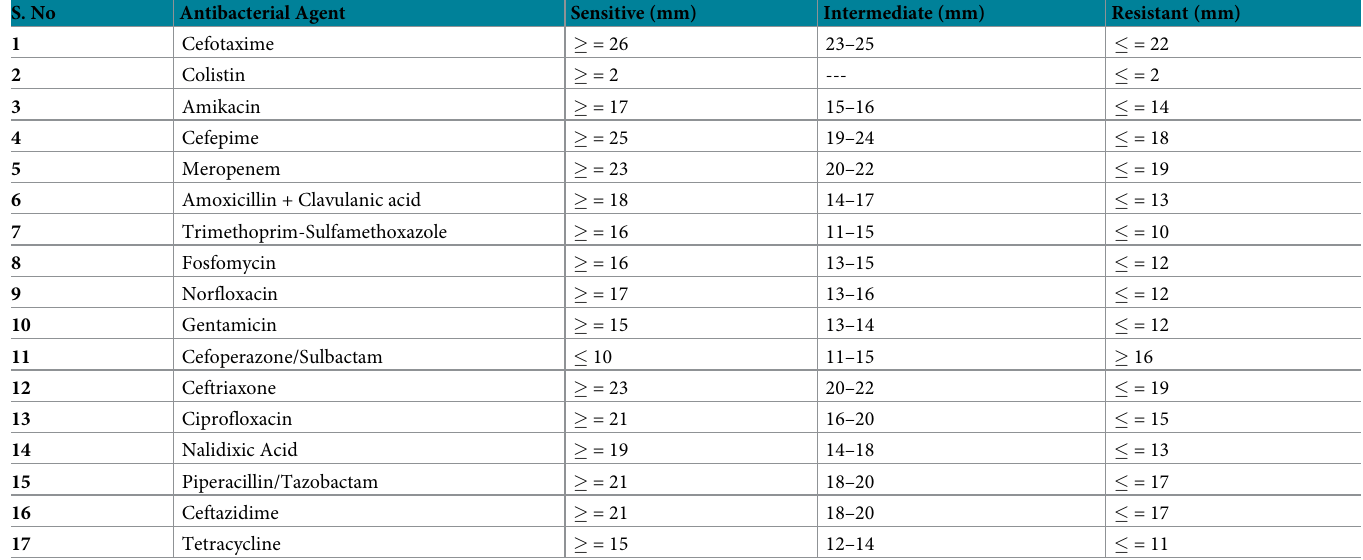
Table 1. List of antibiotics used in the present study.